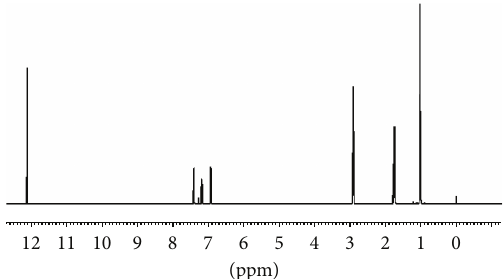
Figure 1: 1 H-NMR spectra of 5-fluoro-2-hydroxy